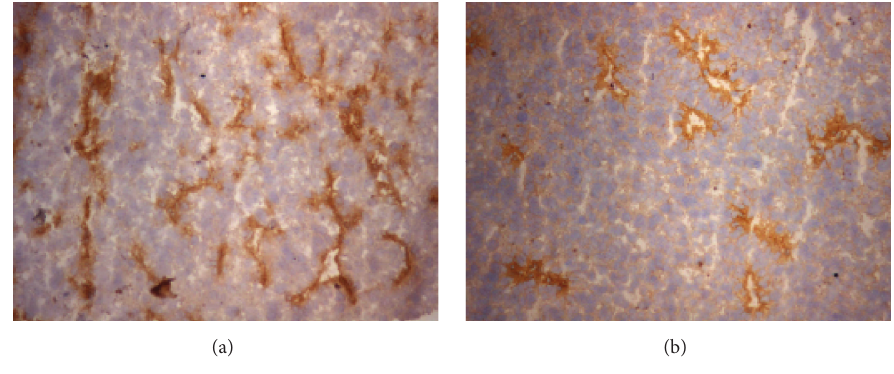
Figure 1: Immunostained vessel